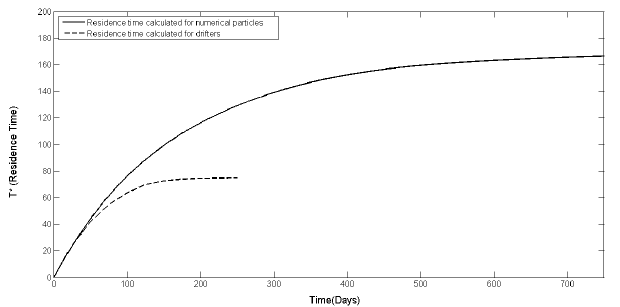
Fig. 6. Residence time T ∗ versus time estimated from the real drifters and the numerical